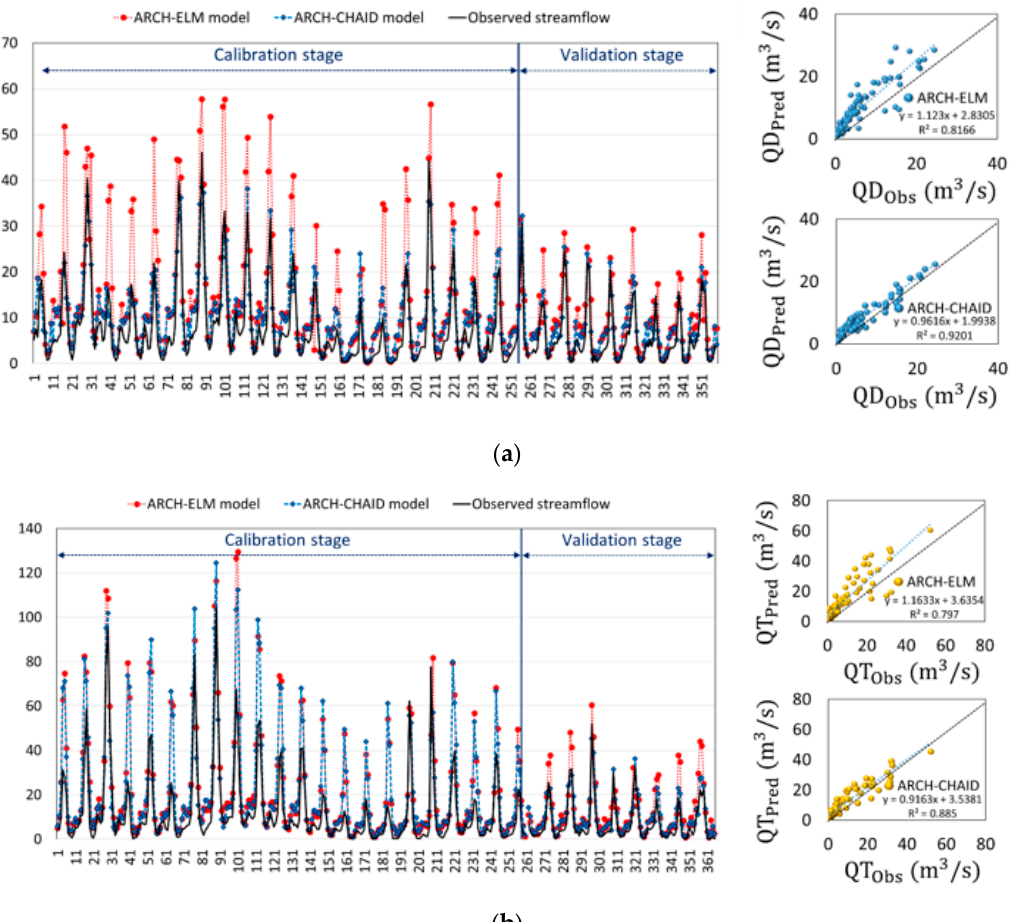
Figure 6. The histograms of observed vs. predicted monthly streamflow using hybrid ARCH-OPELM/CHAID models for calibration and validation stages, and scatter plots of hybrid proposed models in validation stage with least square regression line and coefficient of determination for ( a ) Dizaj and ( b ) Tapik stations.